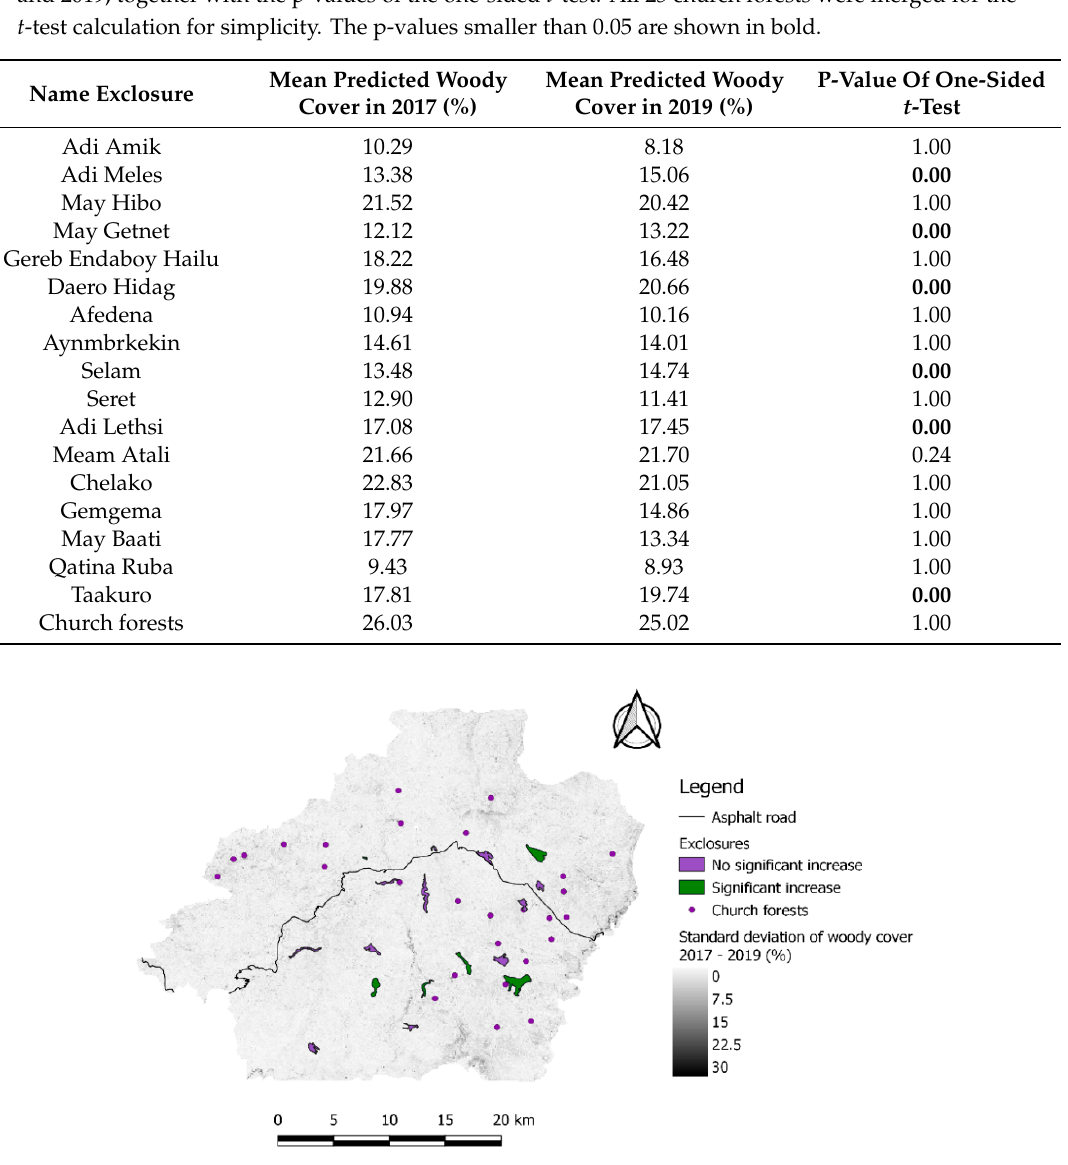
Figure A5. Distance from the four largest villages within the Degua Tembien district, together with the location of the 17 exclosures and 25 church forests included in the analysis. Figure A6. Elevation of the Degua Tembien district, together with the location of the 17 exclosures and 25 church forests included in the analysis.